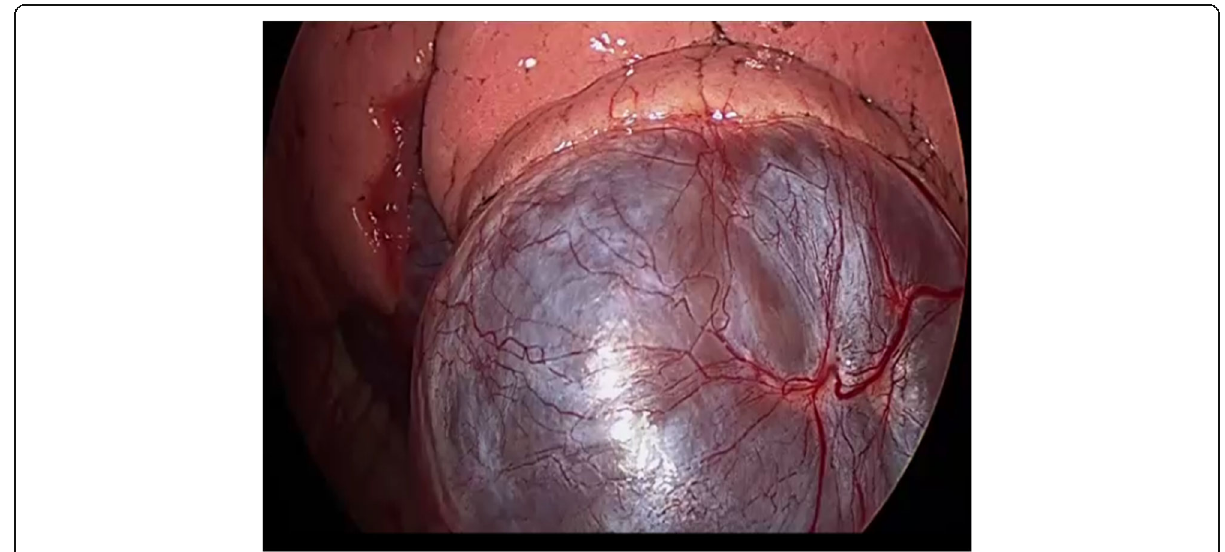
Fig. 3 The intraoperative findings. A cystic tumor was observed in the left lower lobe; no invasion of the surrounding organs was found. The tumor stalk could not be confirmed due to the limitation of the surgical field in the thoracic cavity by the large cystic tumor itself